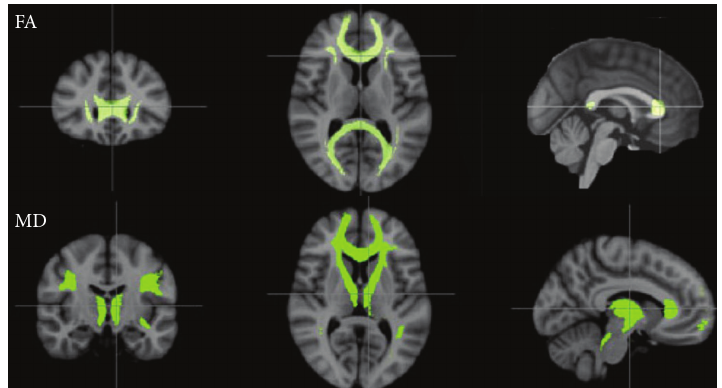
Figure 4: Using the JHU atlas, diffusivity measures were computed for both groups (young and old adults). The upper row represents the regions where the FA values were higher in the younger adults (forceps major and minor, bilateral inferior fronto-occipital fasciculus, and bilateral inferior longitudinal fasciculus). Mean values across areas: .478 (SD = .015) versus .448 (.012). The lower row represents the regions where the MD values were higher in the older population (bilateral anterior thalamic radiation, forceps minor, left IFO, and bilateral superior longitudinal fasciculus). Mean values across regions: .00075 (.00002) versus .00084 (.00006). Table 2: Age effects on white matter quality in the JHU-ROIs. Effect sizes a JHU-ROIs FA MD RD AD .186